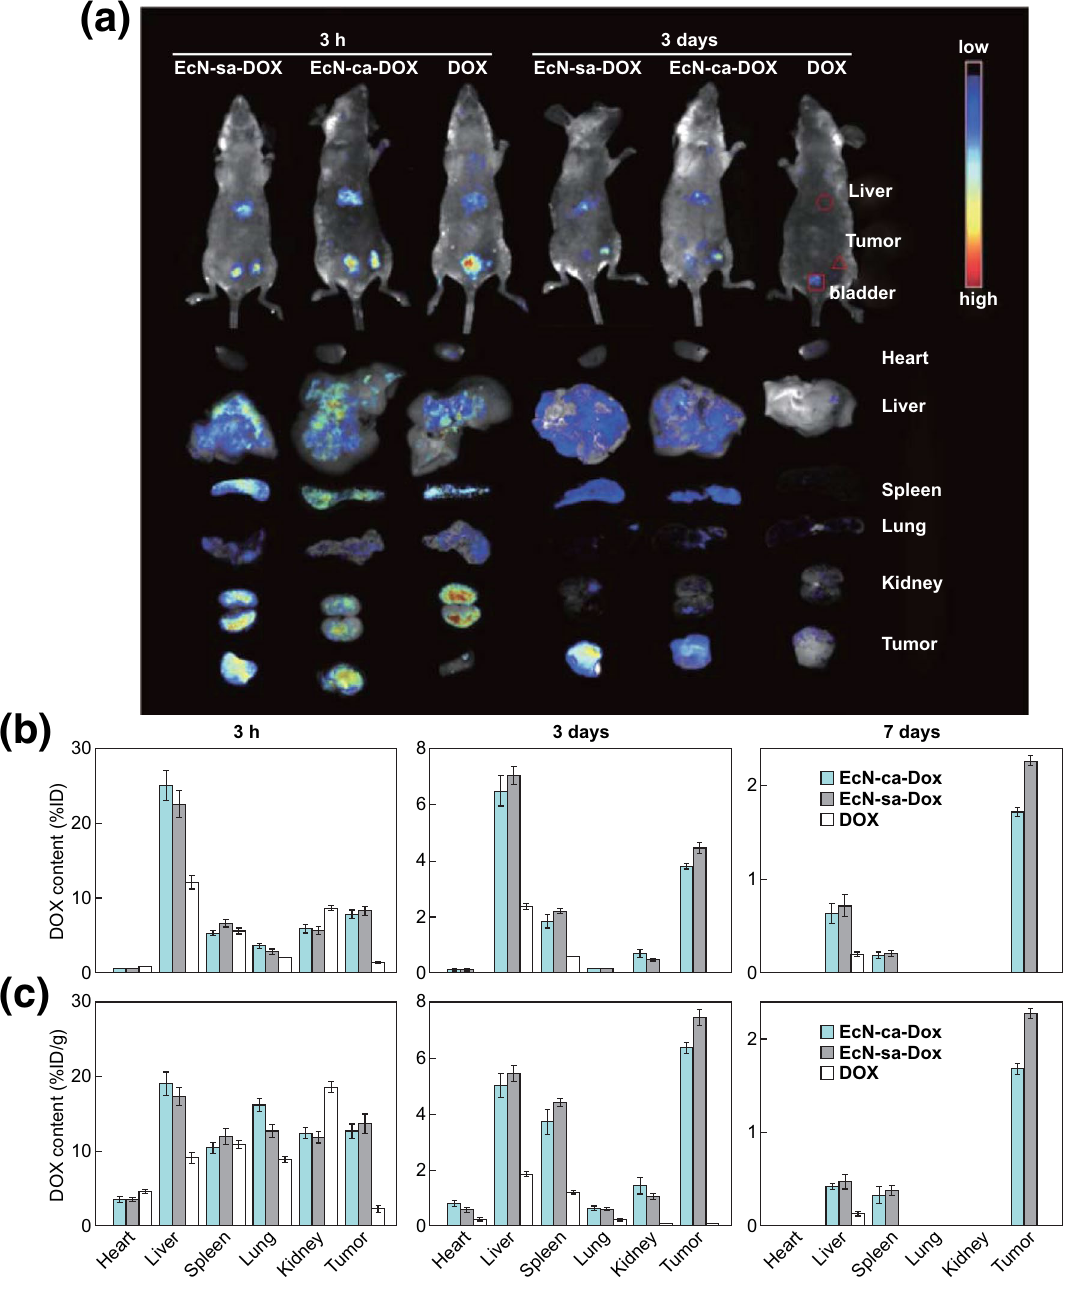
Fig. 1 Confirming the tumor-targeting delivery of EcN. a In vivo fluorescence images of 4T1 tumor-bearing mice and the retrieved organs after intravenous injection of EcN-succinic anhydride-DOX (EcN-sa-DOX), EcN-ca-DOX, and free DOX for 3 h and 3 days. b Percentage of injected dose and c percent dose rate of DOX in above tissues after injection of EcN-sa-DOX, EcN-ca-DOX and free DOX at a dose of 1 mg DOX Kg −1 for 3 h, 3 days and 7 days. Reprinted with permission from Ref.